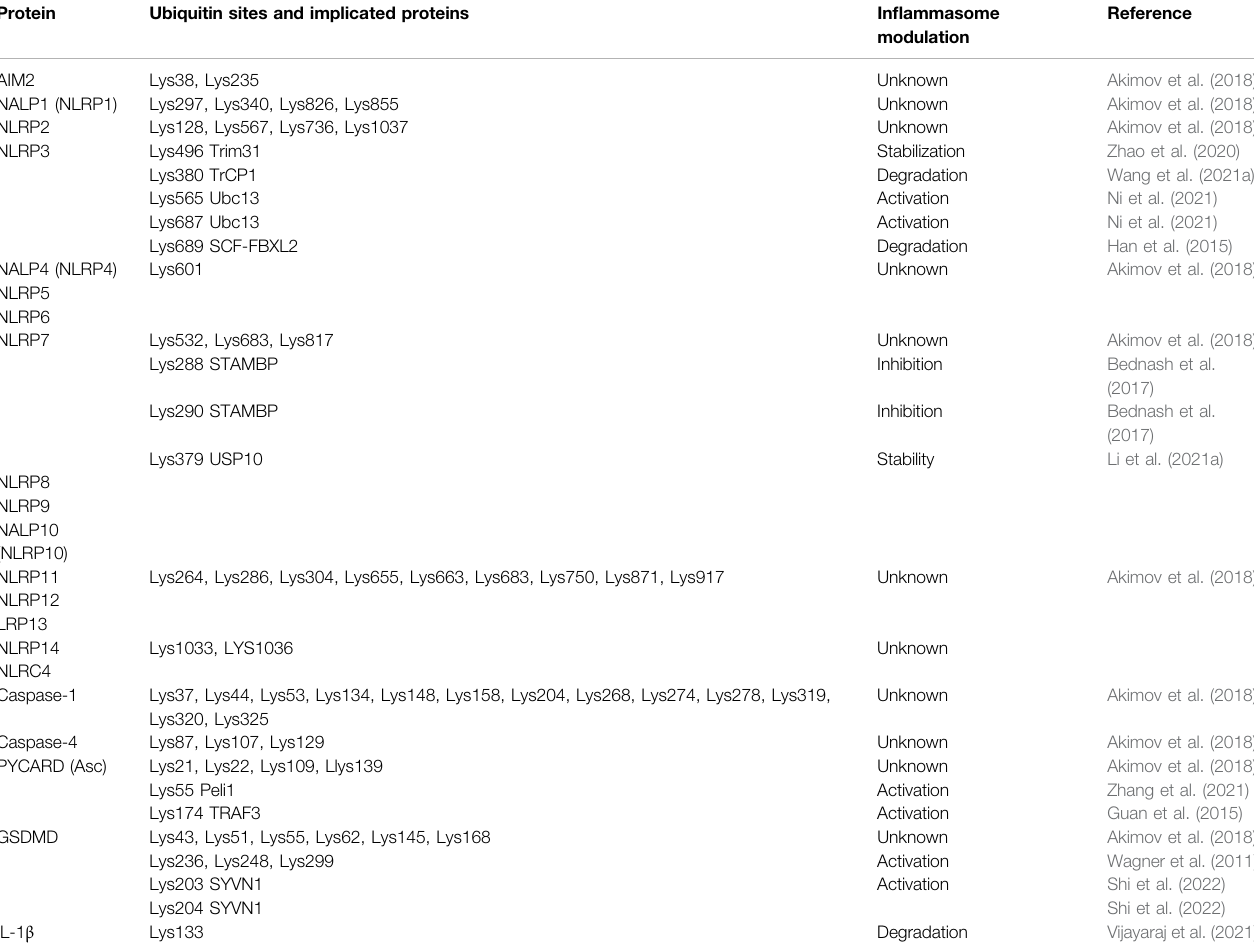
TABLE 2 | Summary of human in fl ammasome ubiquitylation. In orange are represented residues non validated by recorded in PhosphositePlus whereas in green are validated residues. Protein Ubiquitin sites and implicated proteins In fl ammasome